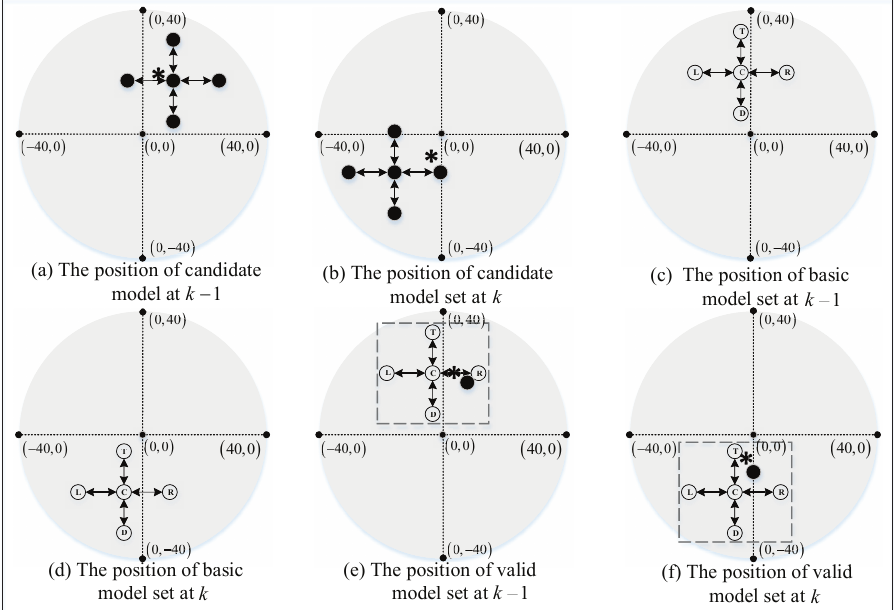
Figure 4. Topology of the model set based on the AG-BMA algorithm.